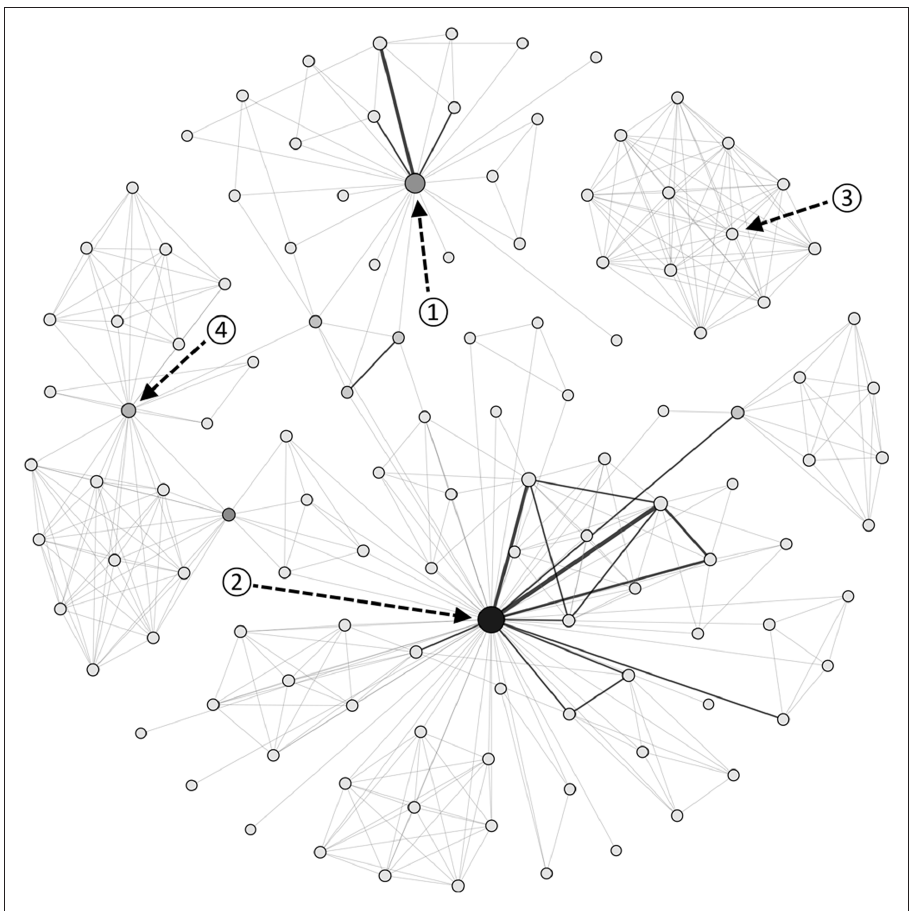
Diagram 7: Co-citation networks, seventh decade: